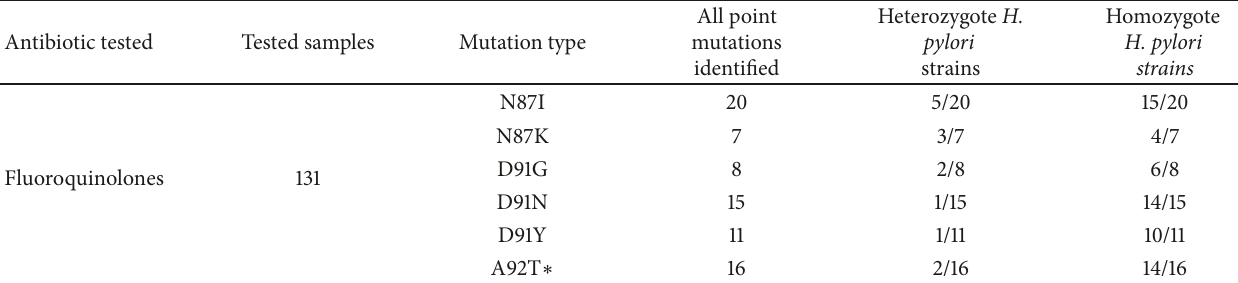
Table 2: Patterns of mutation among 77 patients/samples with point mutations.